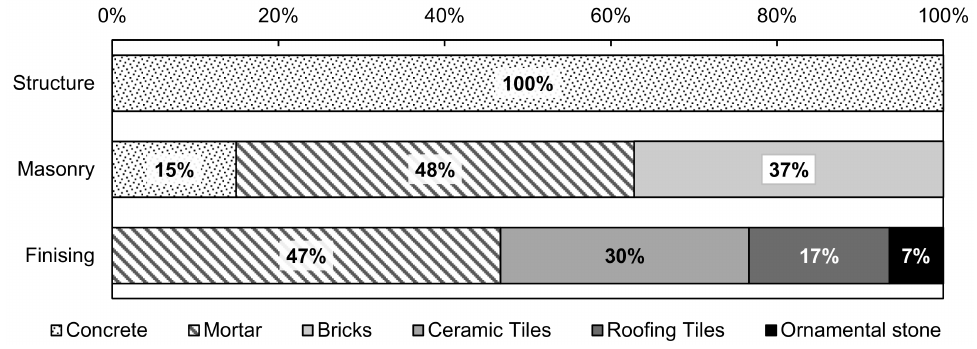
Figure 3. Composition of the waste collected in the construction sites.